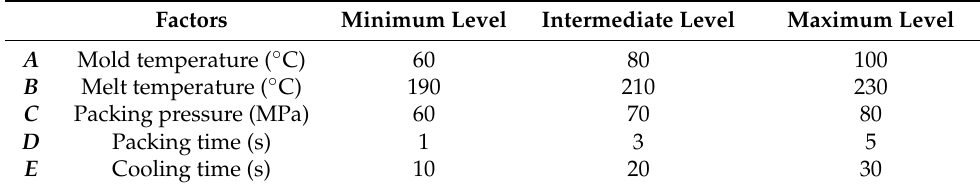
Table 2. Factors and levels of key process